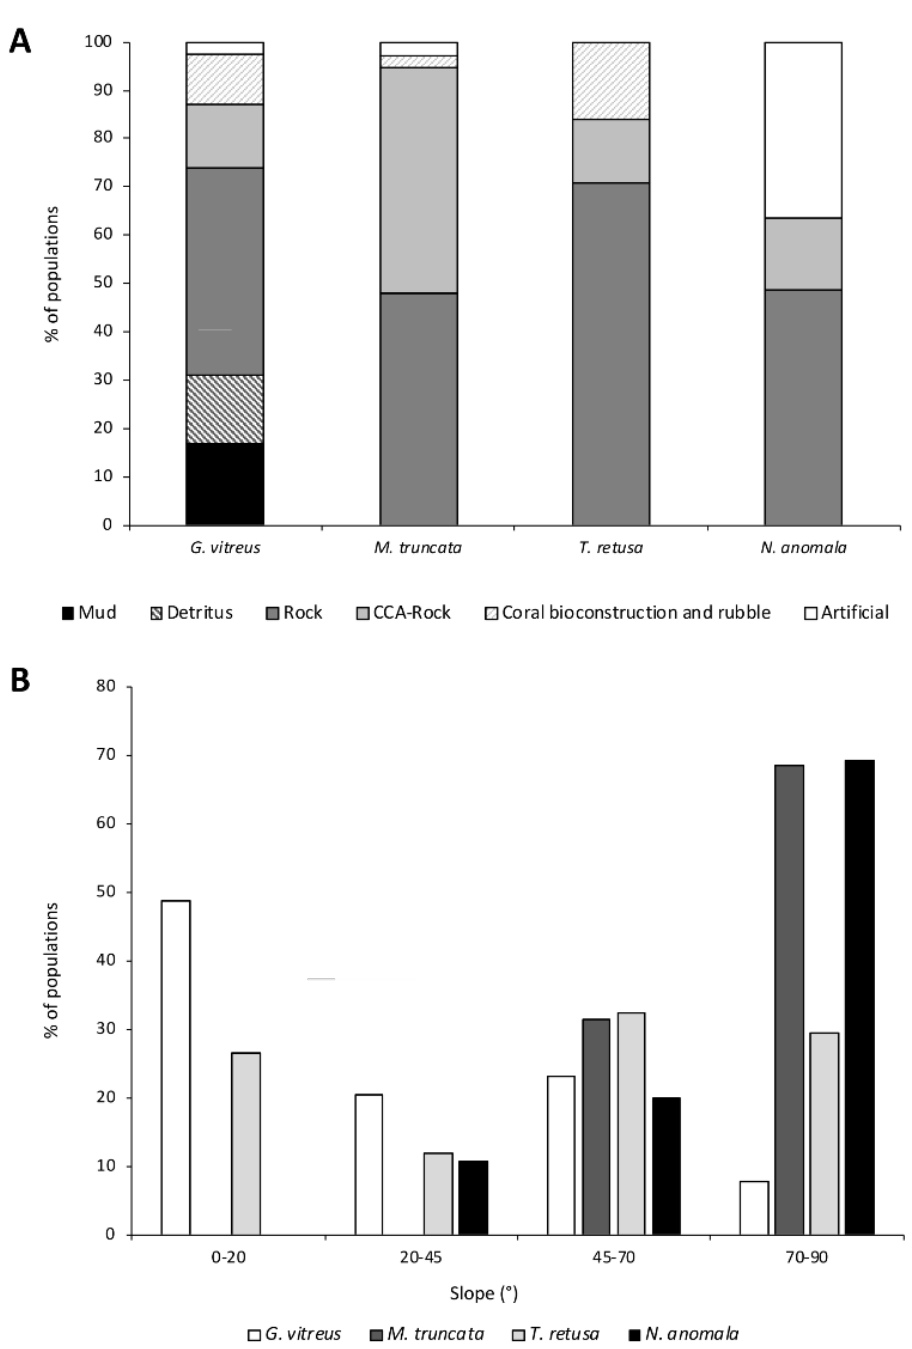
Figure 8. Ecological preferences. ( A ) Percentage of populations of the target species recorded on different substrate types; ( B ) percentage frequency distribution of brachiopod populations with slope.